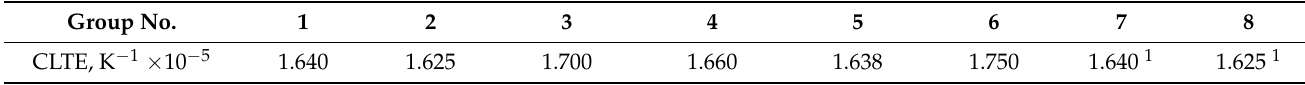
Table 3. Analytically estimated CLTE of all groups based on the CLTE of pure metals.